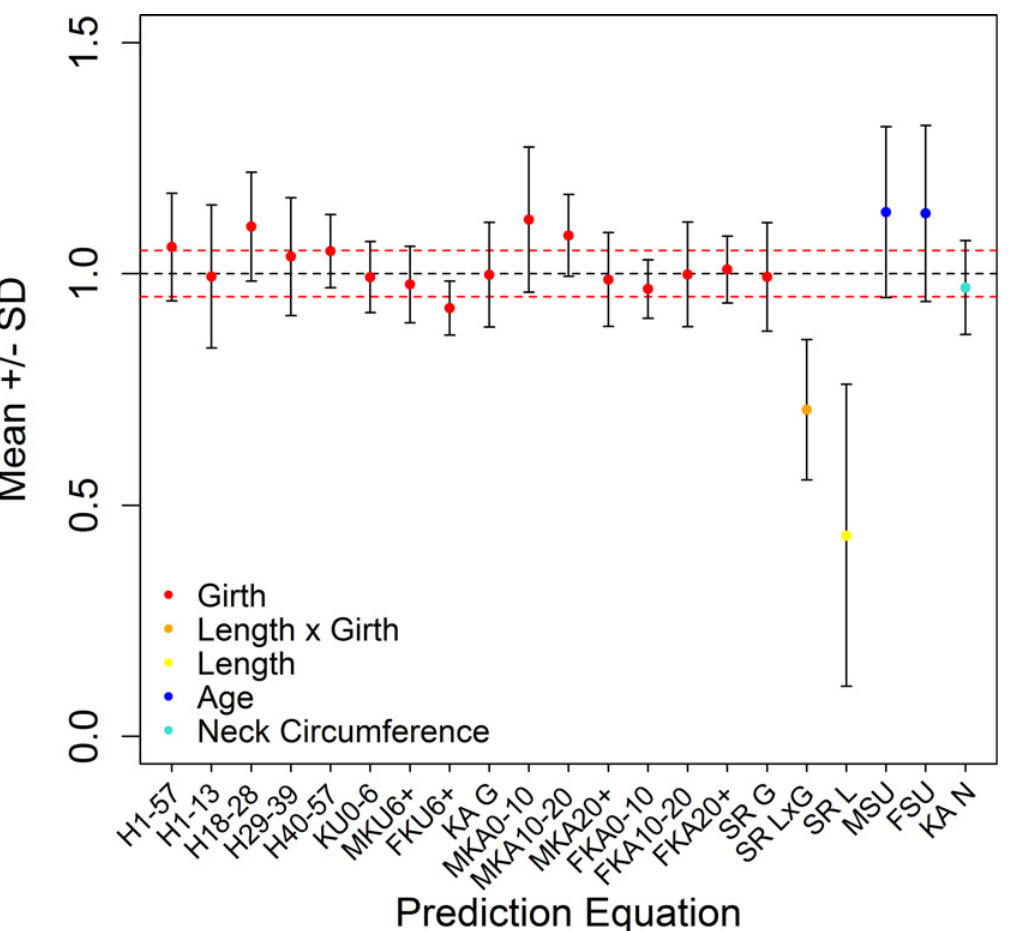
Fig 2. Mean and standard deviations of predicted weights from equations relative to actual weights. Grey bars represent the entire range of the equation and the red dashed line represents 5% above and below one. Colour of circles indicate which parameter was used in the equation. Letter codes in the x-axis labels are as follows: H = Hile et al. [37]; KU = Kurt and Garai [36]; KA = Kanchanapangka et al. [40]; SR = Sreekumar and Nirmalan [39]; SU = Sukumar et al. [38]; G = Chest Girth; L = Length; N = Neck Circumference; F = Female only; M = Male only. Numbers represent the age